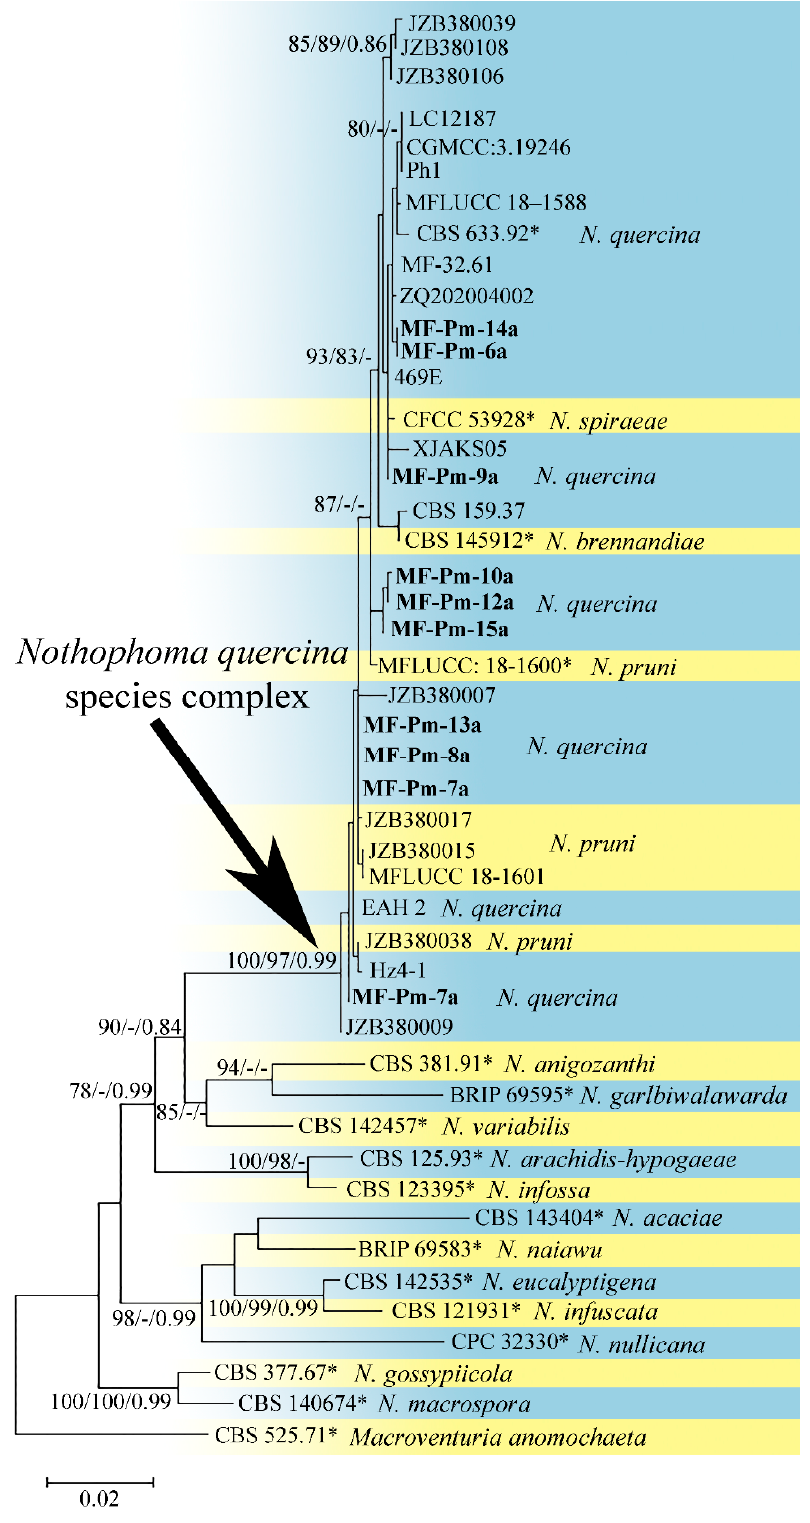
Figure 2. Phylogenetic tree of the Nothophoma species inferred from a maximum likelihood (ML) analysis based on a concatenated alignment of ITS, tub2 , and rpb2 . The ML bootstrap support values (MLBS ≥ 75), MP bootstrap support values (MPBS ≥ 75), and Bayesian posterior probabilities (BPP ≥ 0.75) are given at the nodes (MLBS/MPBS/BPP). Strains isolated in this study are indicated in bold. The ex-type strains are indicated with an asterisk.